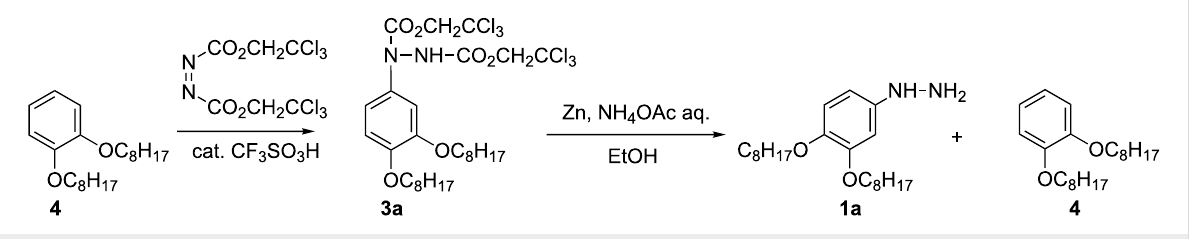
Scheme 1: Formation and deprotection of 3a under reductive conditions.